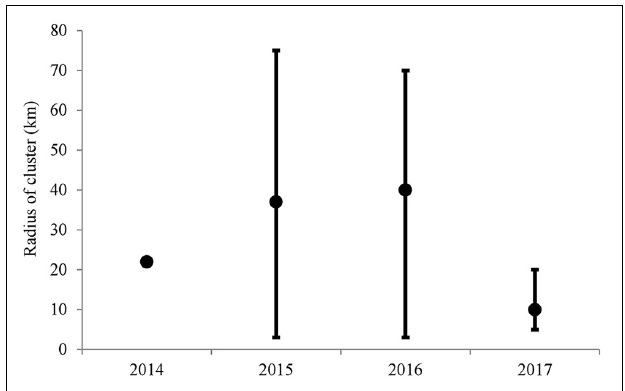
FIGURE 3 | Results of the Ripley’s K analyses of sites surveyed throughout the Florida reef tract from May 2014 to December 2017. The black dots represent the highest Besag’s L value found above the null distribution. The error bars represent the range of values of Besag’s L located above the null